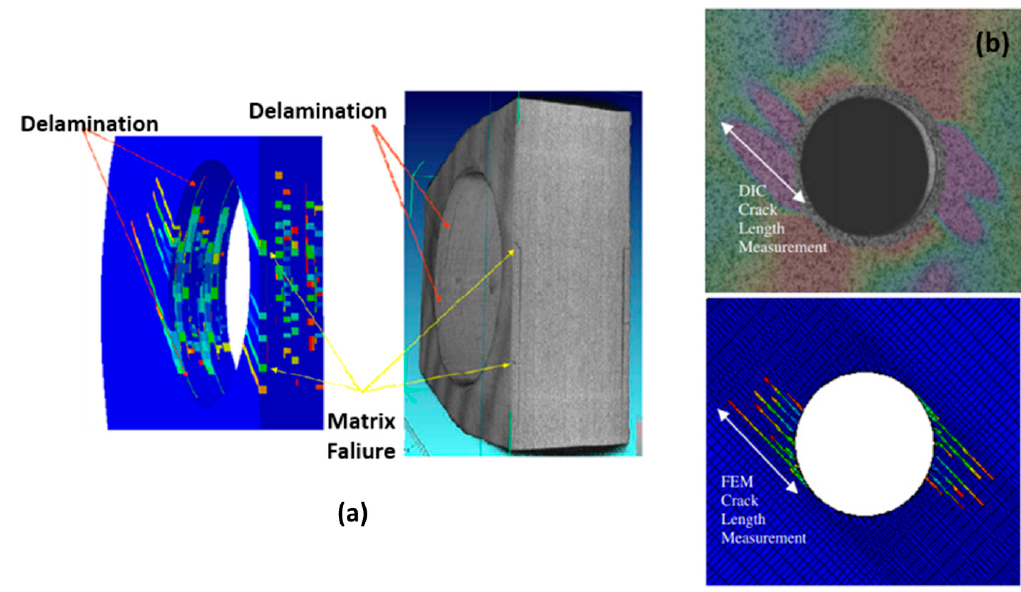
Figure 47. ( a ) Damage occurred in the FEM (left) and in the mechanical test (right). ( b ) Digital Image Correlation with overlapped shear strain (above) and FE damage (below) for the OHT coupon at 1,000,000 cycles. Reproduced with permission [338].